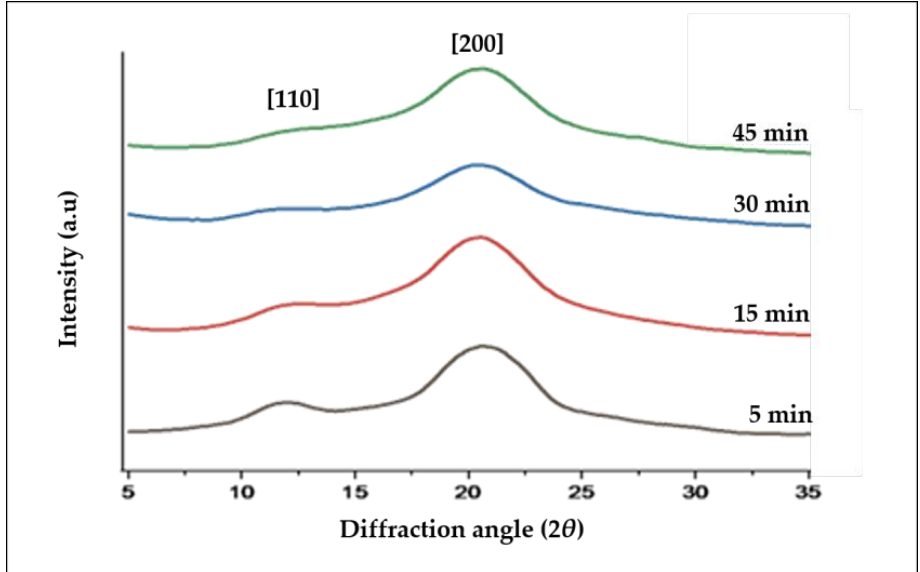
Figure 5. XRD patterns of the ACC film composites at different dissolution time.